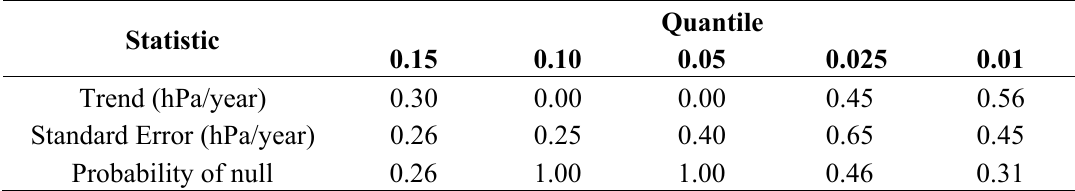
Table 3. Summary statistics for quantile regression